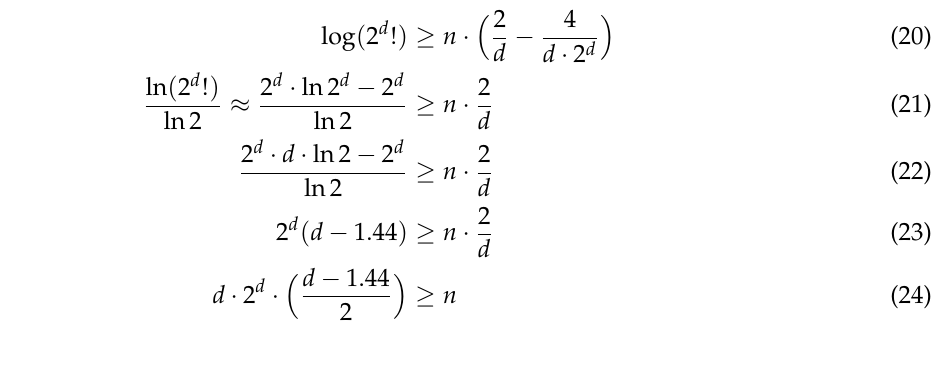
) ) block sizes that are appropriate according 2